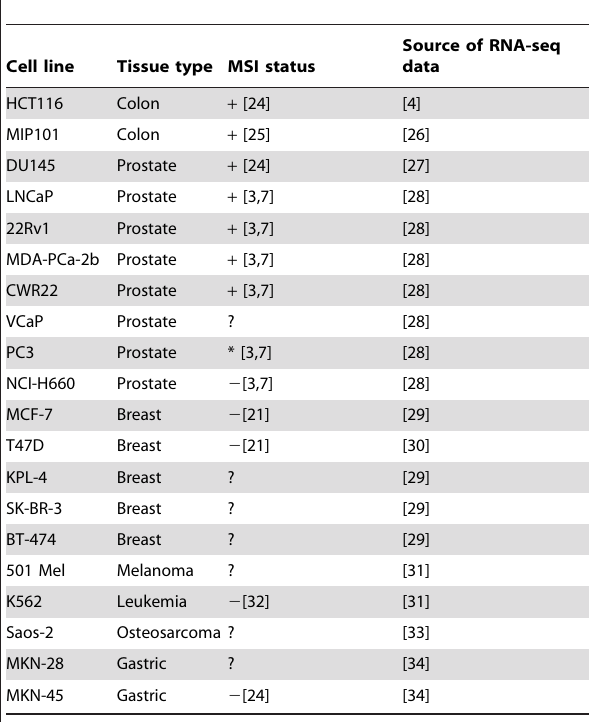
Table 1. Cancer cell lines used in this study and their MSI status described in previous